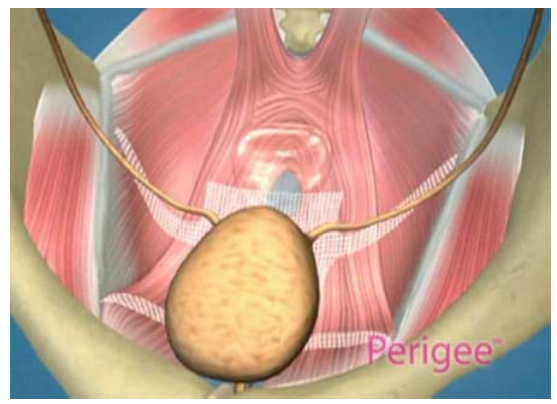
FIGURE 8. Final position of mesh under bladder of Perigee